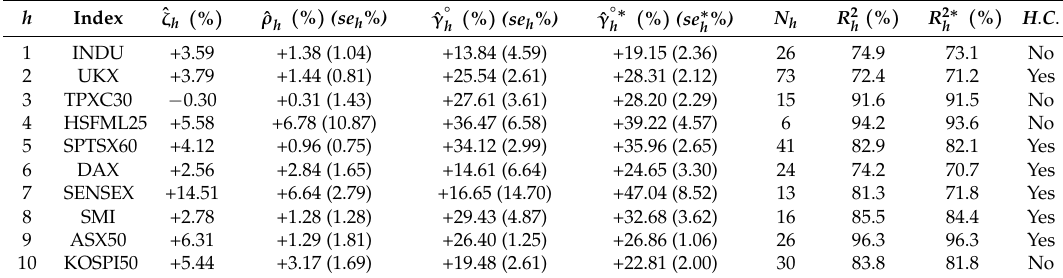
Table 2. Regression Results (Equation (7)): 2005–2014.